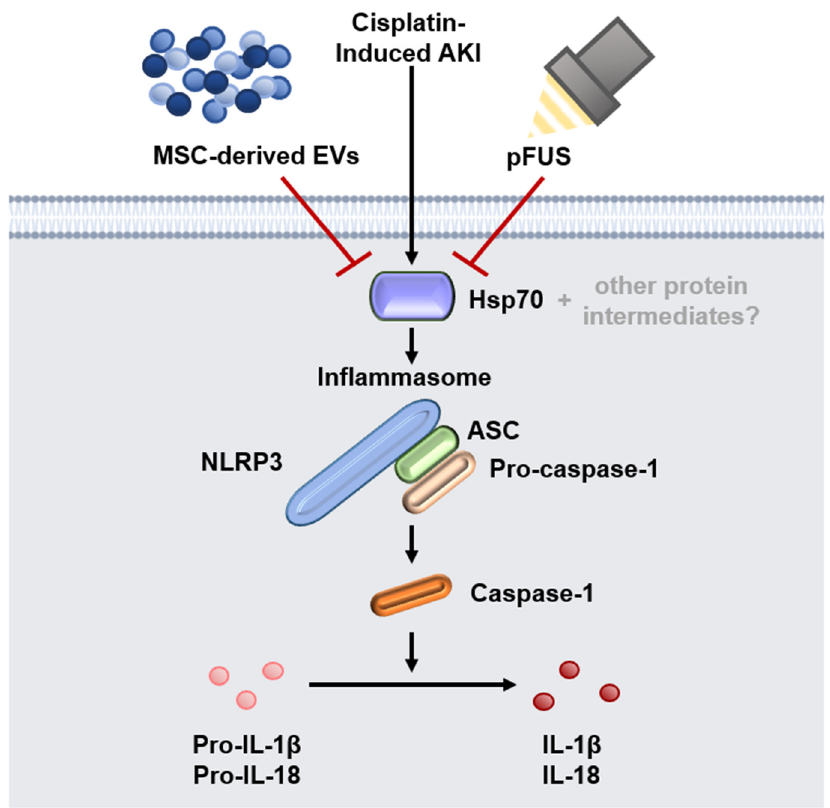
Figure 4. Proposed mechanism of NLRP3 inflammasome suppression. Schematic showing the proposed mechanism by which pFUS and EVs suppress HSP70, the latter of which acts as a positive regulator of the NLRP3 inflammasome.